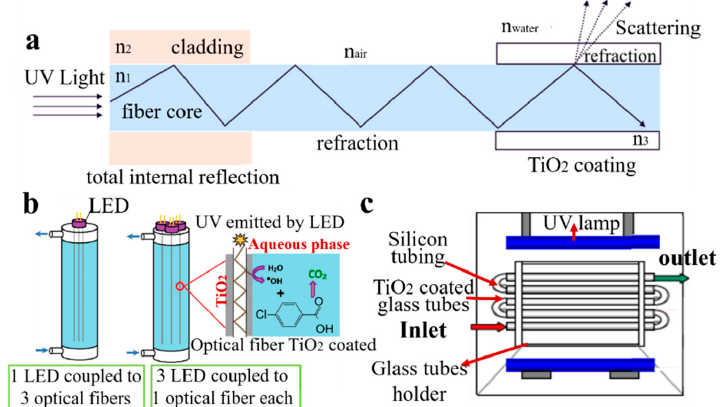
Figure 10. Light transport mechanism through the optical fiber and light delivery to the photocata- lyst ( a ) and schematic of the optical fibers/LED reactor design ( b ) [124]. Copyright 2018, Elsevier. TiO 2 coated glass tubes in the tubular photoreactor chamber ( c ) [126]. Copyright 2004, Elsevier.